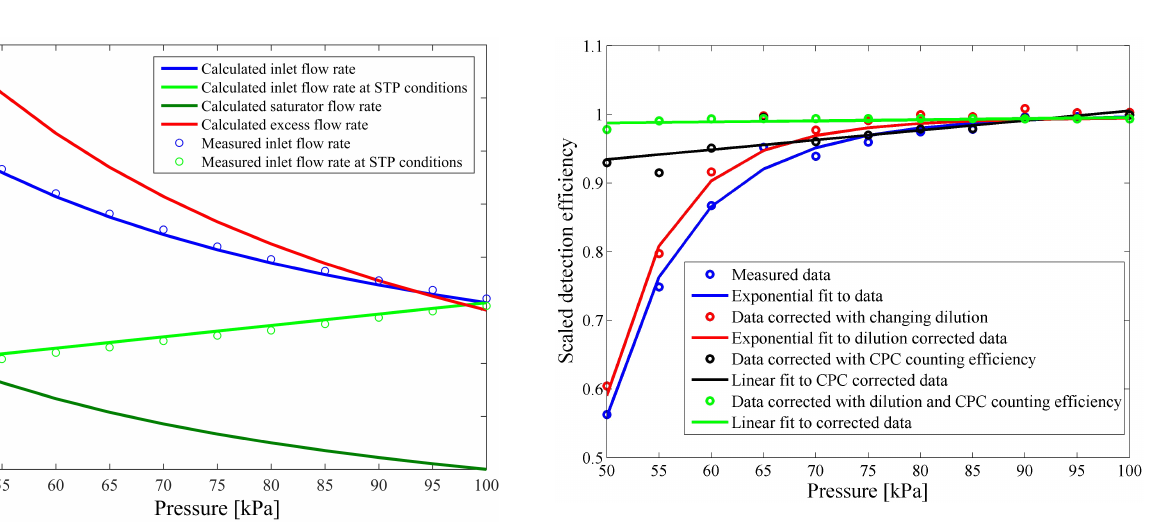
Figure 4. Calculated and measured nCNC flow rates as a function of the inlet pressure.